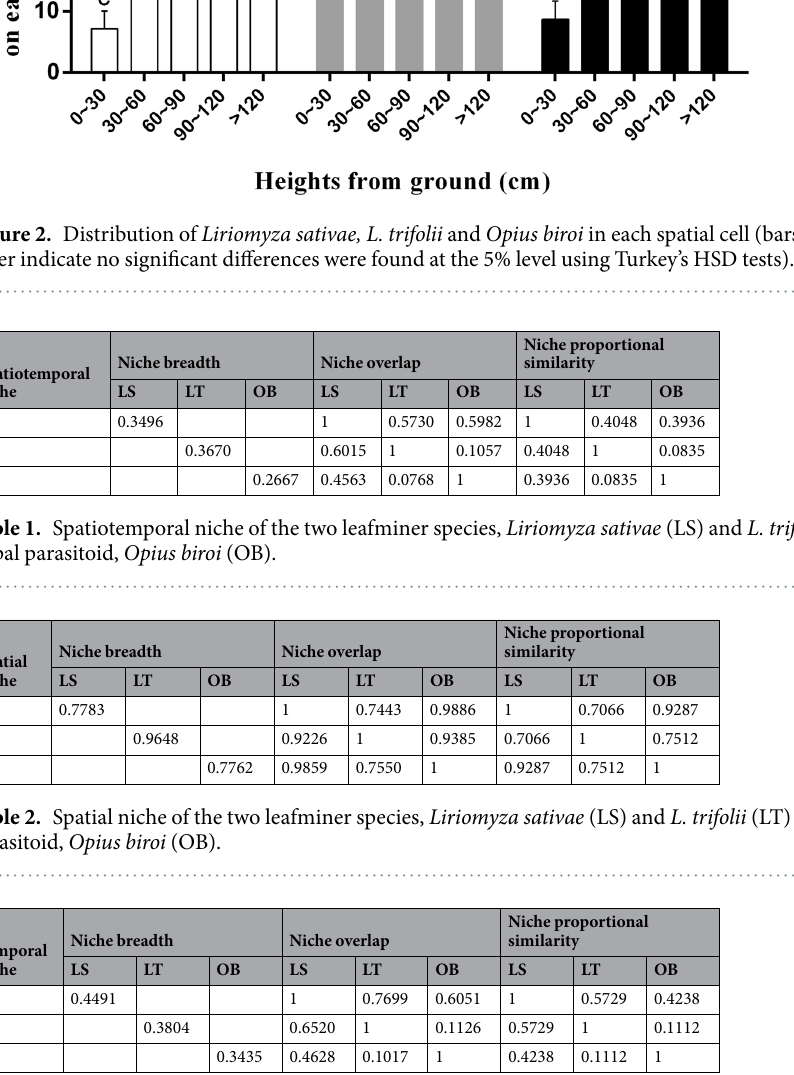
Table 3. Temporal niche of the two leafminer species, Liriomyza sativae (LS) and L. trifolii (LT) and the pupal parasitoid, Opius biroi